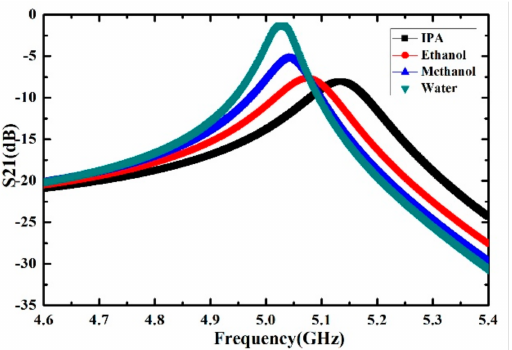
Figure 4. Simulated transmission magnitude curve of the microwave sensor with different liquid samples (IPA, ethanol, methanol and deionized water).